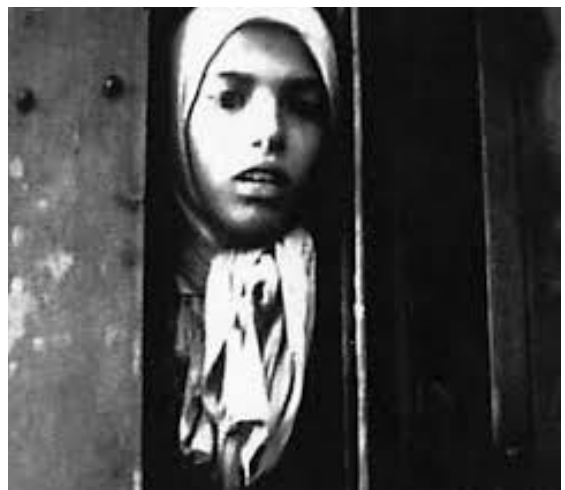
Figure 5. The iconic image of Settela Steinbach from Breslauer’s Westerbork film. Her name was only discov- ered in 1994 after thorough research by a journalist and historians of Herinneringscentrum Kamp Westerbork (Wagenaar, 1995). Source: Netherlands Institute for Sound and